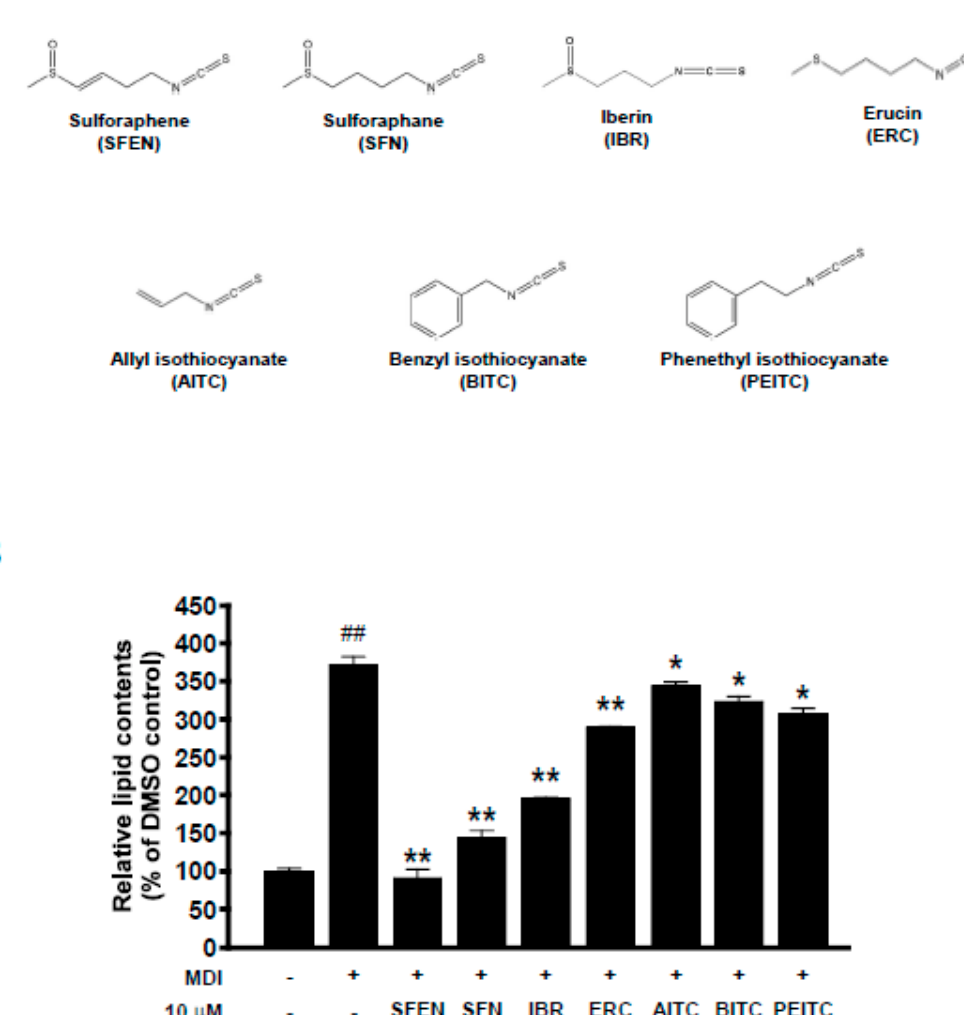
Figure 1. Comparison of e ff ects of several isothiocyanates (ITCs) on di ff erentiation medium-induced lipid accumulation in 3T3-L1 pre-adipocytes. ( A ) Structures of multiple ITCs. ( B ) Results of quantitative analysis using Oil Red O staining. To induce di ff erentiation of the adipocytes, 3T3-L1 pre-adipocytes were seeded in 24-well plates at a density of 1.25 × 10 4 cells per cm 2 , and were maintained in DMEM supplemented with 10% BCS under 10% CO 2 and at 37 ◦ C. Confluent cells were incubated for two days in mouse adipocyte di ff erentiation medium (MDM) with treatment of each sample at a concentration of 10 µ M. MDM contains DMEM supplemented with 10% FBS, 0.5 mM IBMX, 1 µ M dexamethasone, 5 µ g / mL insulin, 100 U / mL penicillin, 100 µ g / mL streptomycin, and 0.25 µ g / mL Fungizone ® (amphotericin B). After two days, the medium was replaced with DMEM containing 10% FBS and 5 µ g / mL insulin with treatment of each sample. After incubation a further two days, the cells were cultured in DMEM containing 10% FBS with treatment of each sample. The medium for control was replaced every two days with DMEM containing 10% FBS. The mature adipocytes were fixed